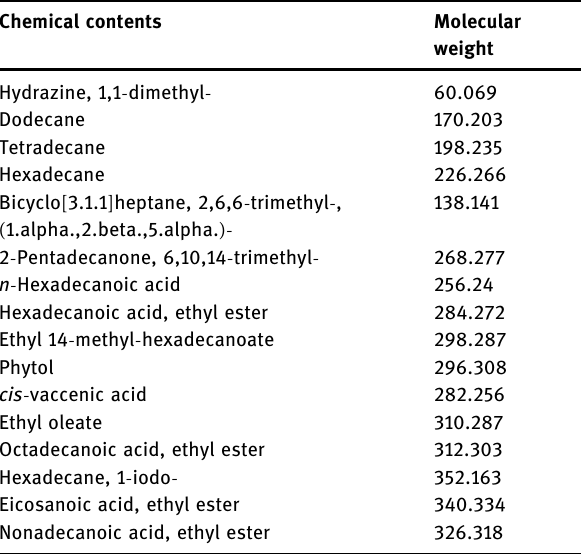
Table 1: The analysis of the chemical content of the R. vesicarius seed extract by the ethanol solvent